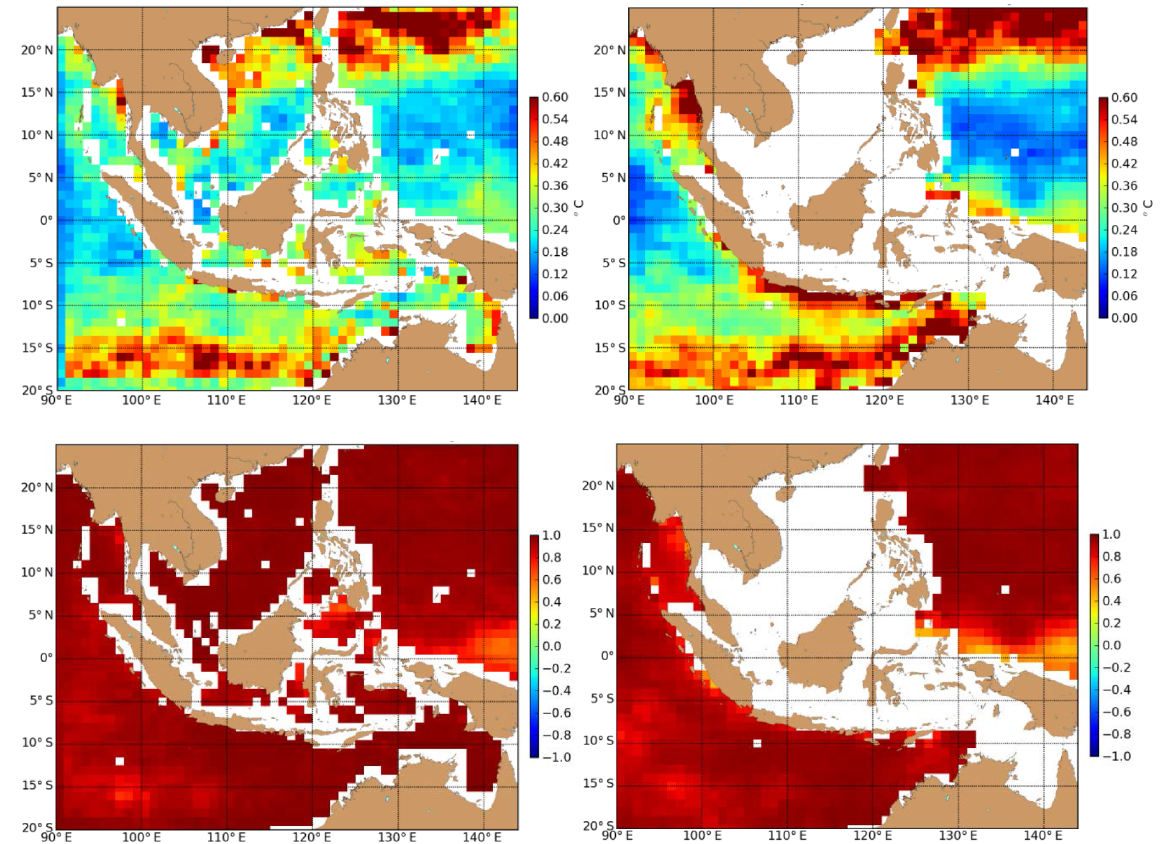
Figure 11. RMSD (top) and correlation (bottom) of INDO12 SST with respect to AMSR-E (left) and JAMSTEC (ARGO + TRITON + CTD) (right) calculated from monthly means